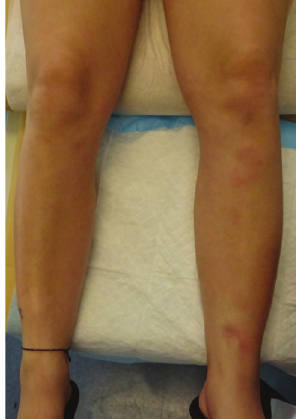
Figure 1: Clinical image depicting violaceous nodules, tender to touch, on the left anterior lower leg.